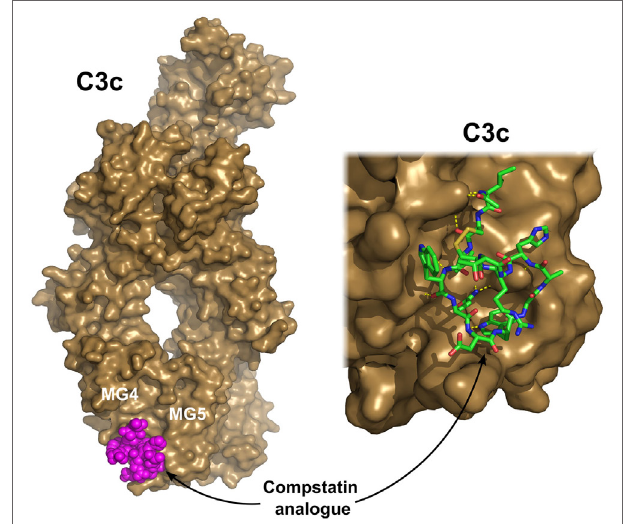
FiGURe 6 | C3c in complex with a compstatin analog. Compstatin, a cyclic peptide, was developed by phage-display. Since its discovery, several modified compstatin analogs have been developed. Compstatin and its analogs bind to C3, C3b, or C3c between the MG4 and MG5 domains. Compstatin sterically prevents the C3-convertase (C3bBb) to access its substrate C3. The depicted structure was determined using the Ac-V4W/ H9A-NH2 variant of the original peptide. The figure was prepared based on the structure by Janssen et al. (170) (PDB entry 2QKI). On the left, the whole structure is shown with C3c (brown) in surface representation and compstatin (magenta) with spheres. On the right, a close-up of the binding site is shown with compstatin represented by sticks. Hydrogen bonds are indicated by yellow dashed